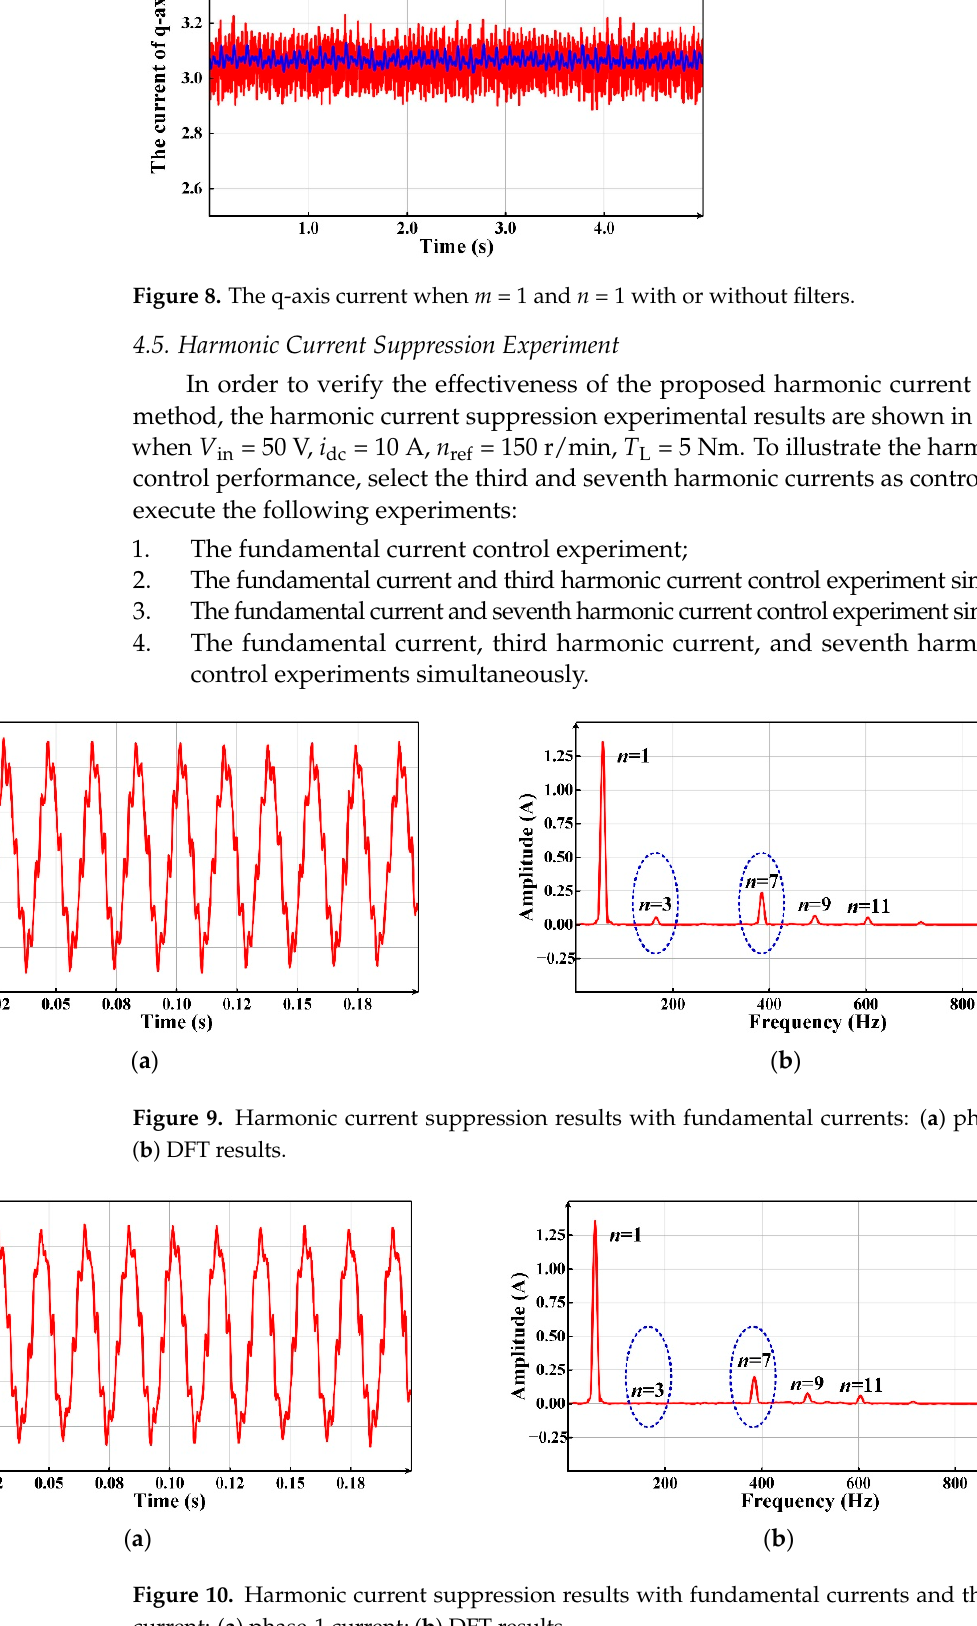
12 of 16 4.3. The DC-Link Current Ratio Experiment The DC-link current ratio experimental results are shown in Figure 7 when V in = 50 V, i dc = 5 A, and the speed reference n ref = 50 r/min. According to the calculation, the max- imum DC-link current ratios of the impulse current PWM technique and SVPWM are all 0.618. When the impulse current PWM technique is selected, Figure 7a shows that the maximum phase current amplitude can reach 3.15 A with the DC-link current of 5.1356 A, and hence the DC-link current ratio is 0.613, which is consistent with the theoretical calculation result. When the SVPWM strategy is adopted, Figure 7b shows that the maxi- mum phase current amplitude is also 3.15 A and the DC-link current is 5.1054 A, and the DC-link current ratio is 0.617, which is almost the same as that of the impulse modulation strategy. The experimental results indicate that the two modulations have the same per- formance in terms of the DC-link current ratio. ( a ) ( b ) Figure 7. The DC-link current ratio: ( a ) impulse current PWM technique; ( b ) SVPWM. 4.4. The Experiment with SDFT-LPF In order to verify the effectiveness of SDFT-LPF, the experimental results are shown in Figure 8 when V in = 50 V, i dc = 10 A, n ref = 50 r/min, T L = 5 Nm. Since the number of pole pairs of the PMSM is 22, then the fundamental frequency of the phase currents is 18.33 Hz. From the above analysis, the d–q axis components are all the superposition of a con- stant component and a series of sinusoidal components after the transformation of the five-phase currents in the m th harmonic space. When m = 1 and n = 1, according to Equa- tions (26)–(28), the lowest frequency of the sinusoidal components is 183.3 Hz. Considering the storage space and filtering performance, the sampling points of the